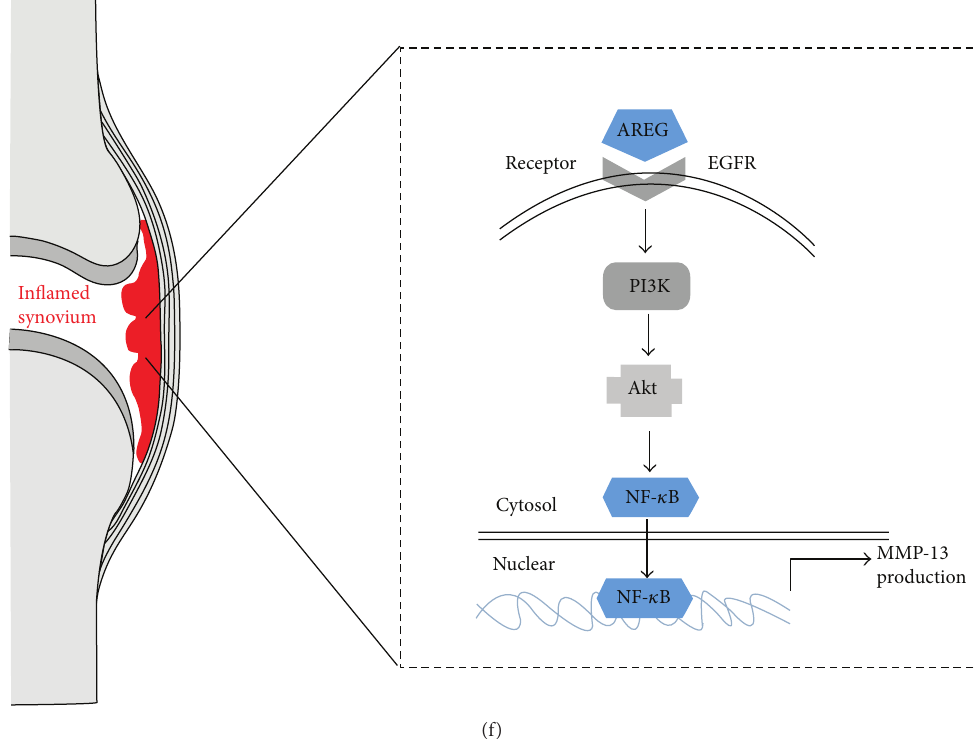
Figure 5: AREG induced NF- 𝜅 B activation through EGFR/PI3K/Akt pathway. ((a), (b), and (c)) OASFs were incubated with various concentrations of AREG or pretreated with PI3K inhibitors (LY294002 (5 𝜇 M) and Wortmannin (0.5 𝜇 M)), Akt inhibitor (Akti (5 𝜇 M)), or NF- 𝜅 B inhibitors (PDTC (5 𝜇 M), or TPCK (5 𝜇 M)) for 30 min or transfected with PI3K, Akt, IKK 𝛼 , and IKK 𝛽 mutant before exposure to AREG. NF- 𝜅 B luciferase activity was measured, and the results were normalized to the 𝛽 -galactosidase activity. (d) OASFs were pretreated with LY294002, Wortmannin, or Akti for 30 min and then stimulated with AREG for 120 min, and p65 immunofluorescence staining was examined. (e) OASFs were pretreated with LY294002, Wortmannin, or Akti for 30min followed by stimulation with AREG for 60 min, and p-p65 expression was examined by Western blot analysis. (f) Schematic presentation of the signaling pathways is involved in AREG-induced MMP-13 production in human synovial fibroblast. Results are expressed as the mean ± SEM (𝑛 = 4) . ∗ 𝑃 < 0.05 compared with control; # 𝑃 < 0.05 compared with AREG-treated